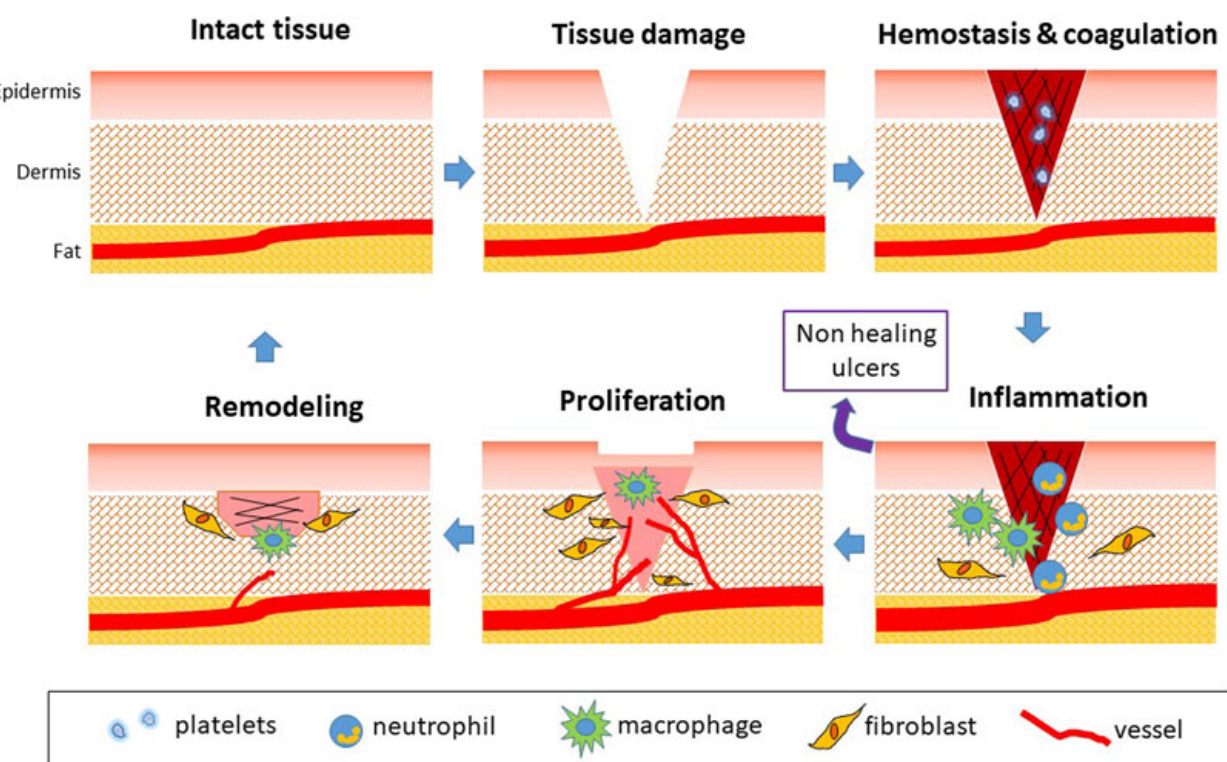
Figure 1. Phases of physiological wound healing. Reproduced with permission [7].